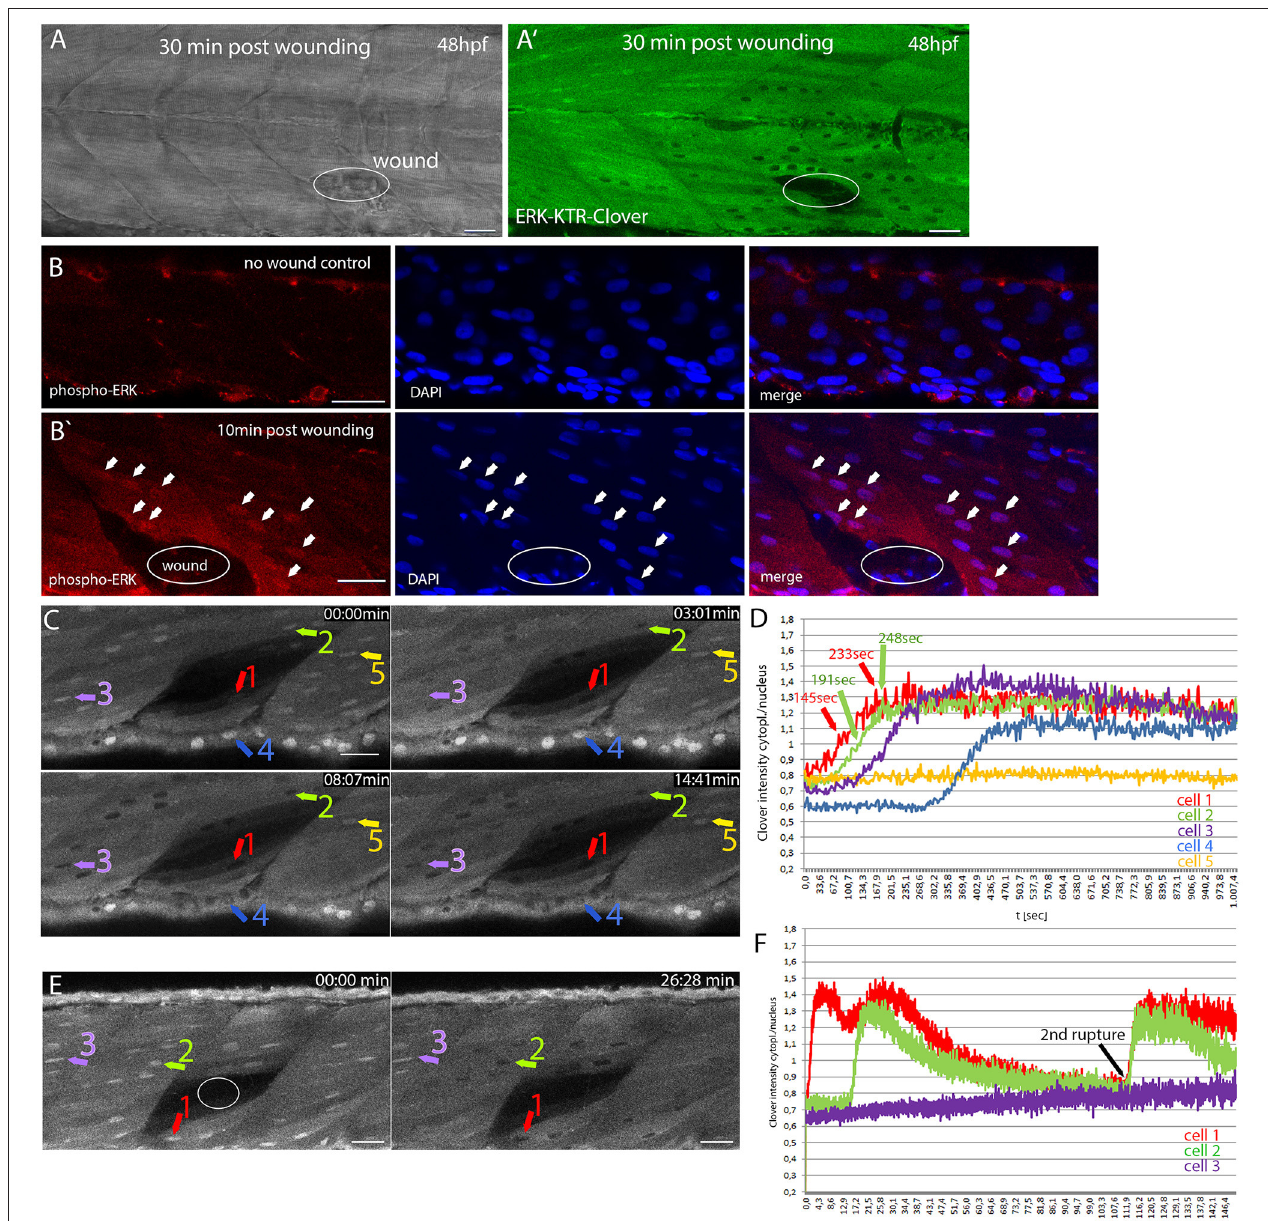
FIGURE 2 | Monitoring dynamic Erk activity in DREKA zebrafish (A) Brightfield image and fluorescence image (A ′ ) of a DREKA embryo wounded with a glass needle at 48 hpf. Images were taken 30min after wounding. Active Erk signaling was observed in muscle cells around the wound ( n = 6 embryos). (B) Immunofluorescence staining for phosphorylated Erk (red) in muscle cells of control and zebrafish embryos wounded with a glass needle 10min post-wounding (B ′ ) . DAPI staining is shown in blue. Arrows mark some of the cells with phosphorylated Erk being visible in the nucleus surrounding the wound (circle). (C) Erk signaling activation in muscle and skin epithelial cells after laser induced wounding in 54 hpf DREKA. Four time points (0, 3, 8, and 14min) taken from time-lapse Movie 3 show the fast activation of Erk signaling. (D) Quantification of Erk activity in 5 cells as depicted in (C) starting ∼ 65s post-wound appearance. Erk activity is shown as cytoplasmic/nuclear ratio of mClover intensity over time (seconds). Cells close to the wound [#1(red) and #2(green)] show a fast response with higher reporter concentrations in the cytoplasm compared to the nucleus around 145s (cell #1) and 191s (cell #2) post-wound appearance and peaking after ∼ 233s (cell #1) and 248s (cell #2), respectively. Cells further away respond later [#3(purple)] or remain inactive [#5(yellow)]. In addition to muscle cells, Erk signaling activation was also observed in skin epithelial cells [#4(blue)]. (E) Erk signaling activity in response to laser induced wounding of muscle cells in 72 hpf DREKA. mClover fluorescence (shown in gray) at 0 and 26min after the wound (circle) has been introduced (see Movie 4 ). After wounding mClover starts to localize from the nucleus to the cytoplasm in cells directly adjacent to the wound, indicating Erk signaling activation (cell #1). Muscle cells further away from the wound become active for Erk signaling at later time points (cell #2) or remain inactive (cell #3). (F) Quantification of Erk activity in 3 cells as shown in (E) over 2.5h starting ∼ 40s post-wound appearance (see Movie 4 ). Erk signaling activity is shown as cytoplasmic to nuclear mClover intensity over time (minutes) for one muscle cell close to the wound (#1 red), one muscle cell further away (#2 green), and one non-responding muscle cell (3# purple) (colored arrows in E) . Note the second rupture event leading to a rapid activation of Erk signaling. All scale bars are 25 µ m. All images were recorded on a Leica SP8 X WLL confocal microscope and rendered using Photoshop CS6.